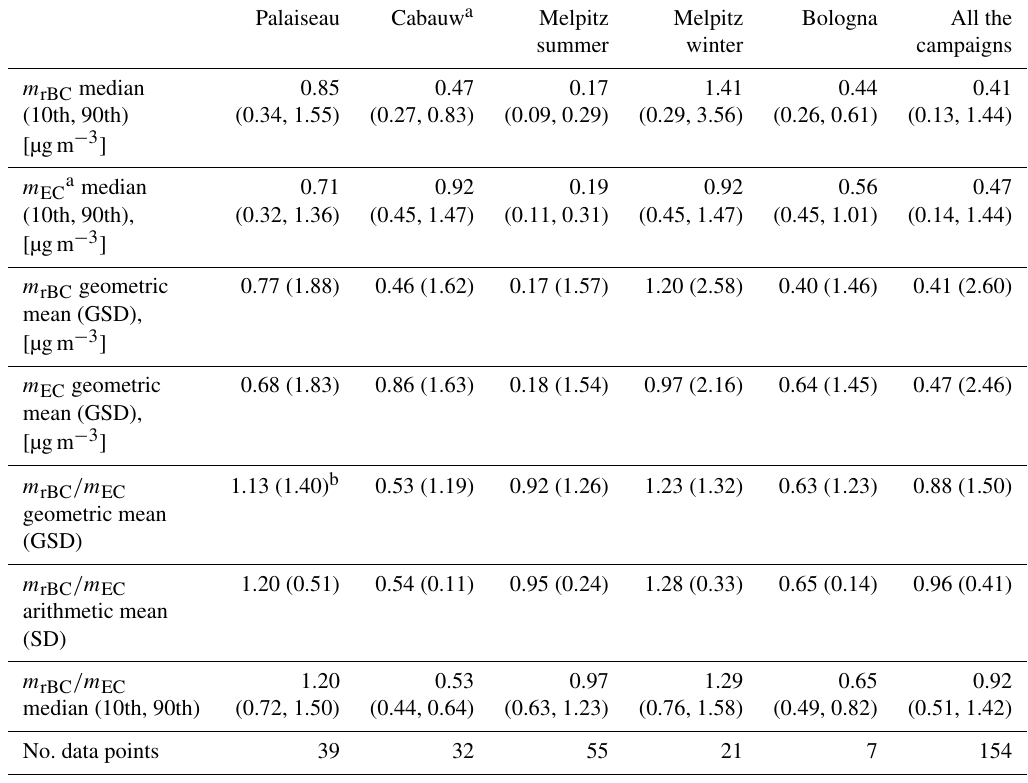
Table 5. The m rBC and m EC statistics per campaign: median, arithmetic and geometric mean, geometric standard deviation (GSD), standard deviation (SD), 10th and 90th percentiles, and number of data points.